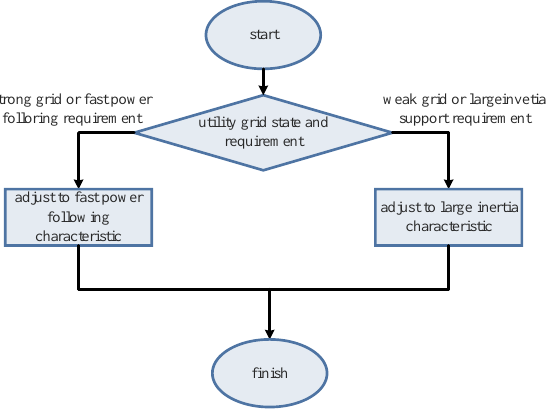
Figure 10. Flow chart of characteristics transition according to grid state and requirement.